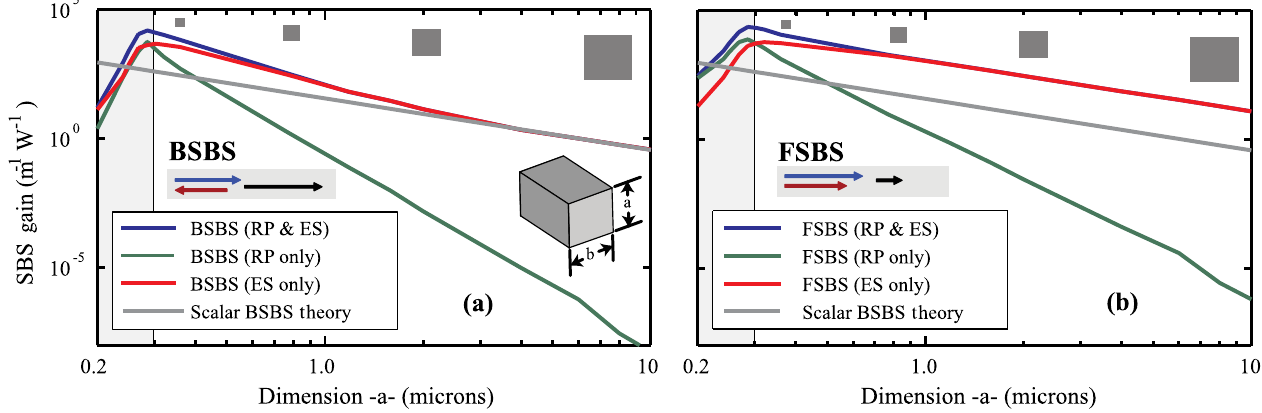
FIG. 5. Computed SBS contributions from electrostriction (ES) and radiation pressure (RP) as the waveguide dimension, a , is varied from 0.2–10 microns (for b ¼ 0 : 93 a ). (a) BSBS gain resulting from ES (red), RP (green), and the coherent combination of both ES and RP (blue). (b) An identical set of curves for FSBS. In comparison, the conventional microscale SBS theory (gray curves) underestimates the BSBS gain by up to 2 orders of magnitude for length scales between 250 nm and a few microns. For further details on the microscale SBS trend (gray curves), see Appendix A. The dimensions where radiation pressure is dominant are shaded